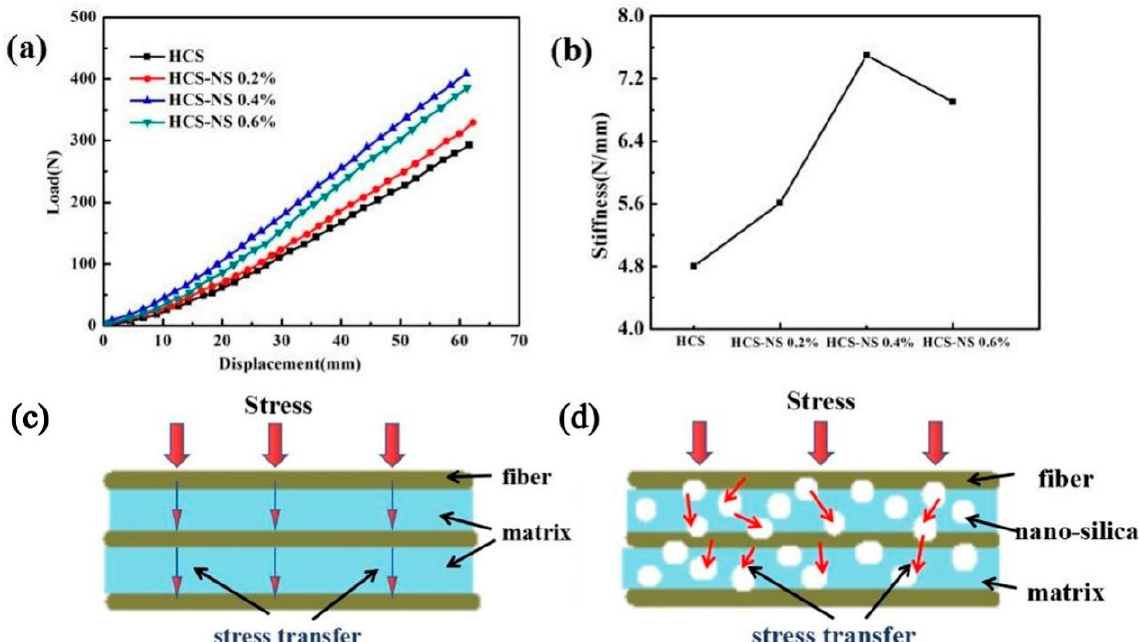
Figure 4. ( a ) Load ‐ displacement curves of helical spring compression test; ( b ) the curve of static stiffness of helical spring; ( c ) schematic diagram of composite stress transfer of pure fiber composite; ( d ) schematic diagram of nano ‐ silica ‐ fiber ‐ reinforced epoxy resin composite stress transfer.